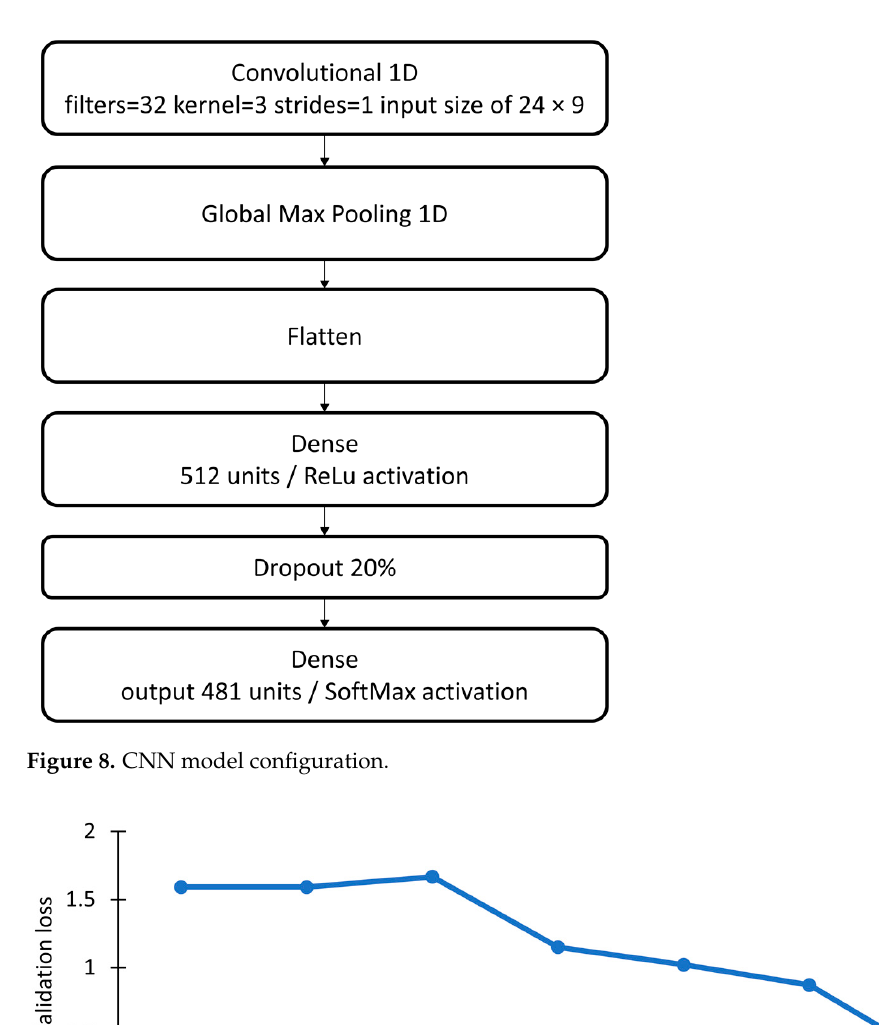
Figure 9. Evolution of the validation error during the hyperparameter fine-tuning process.